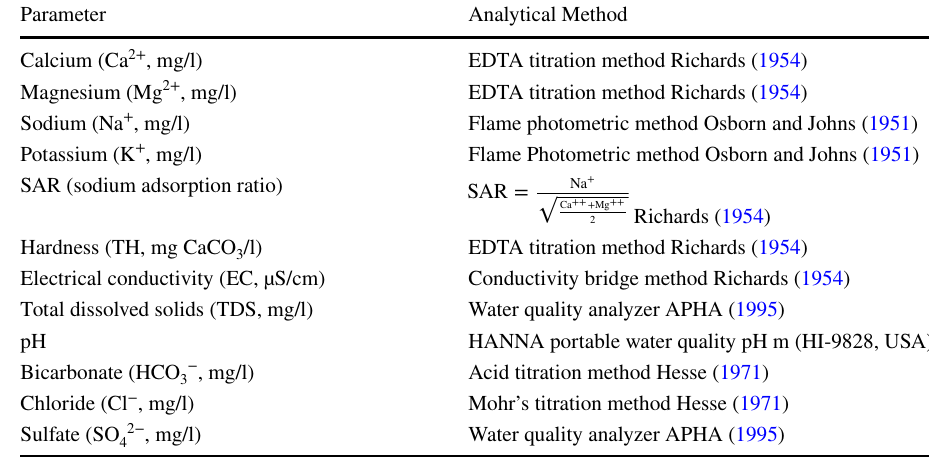
of measurement of different physiochemical parameters of groundwater